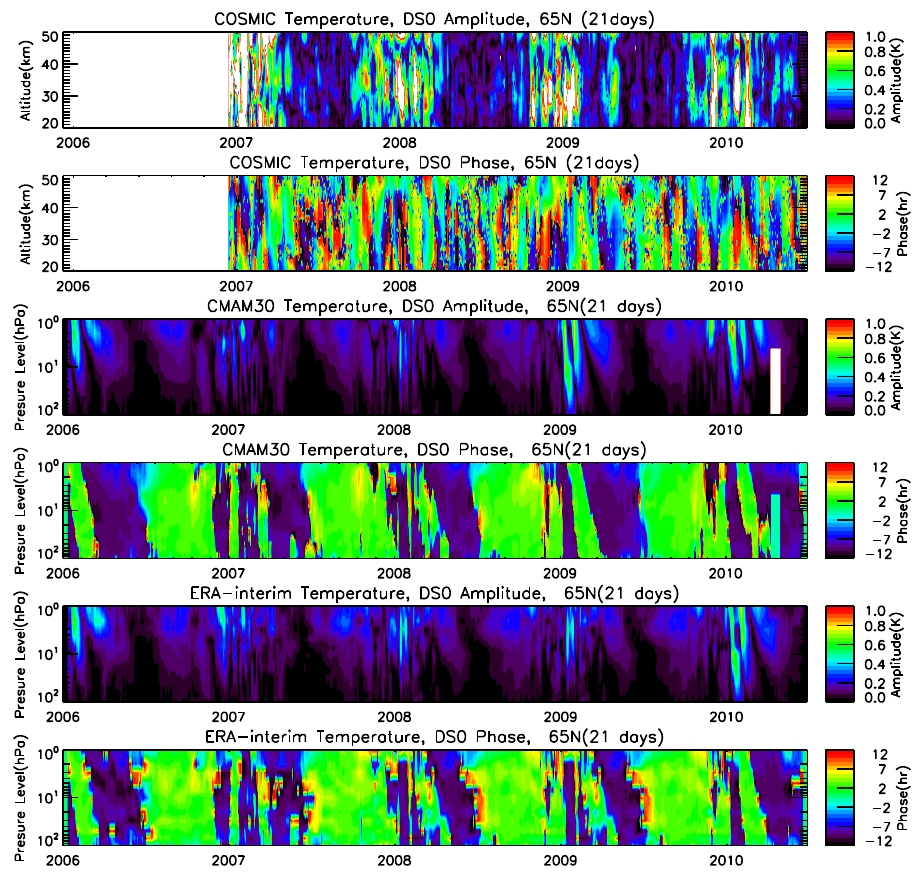
Figure 2. Amplitudes and phases of DS0 tide over 65 ◦ N from COSMIC observations, CMAM30, and ERA-interim reanalysis datasets using ± 10 days